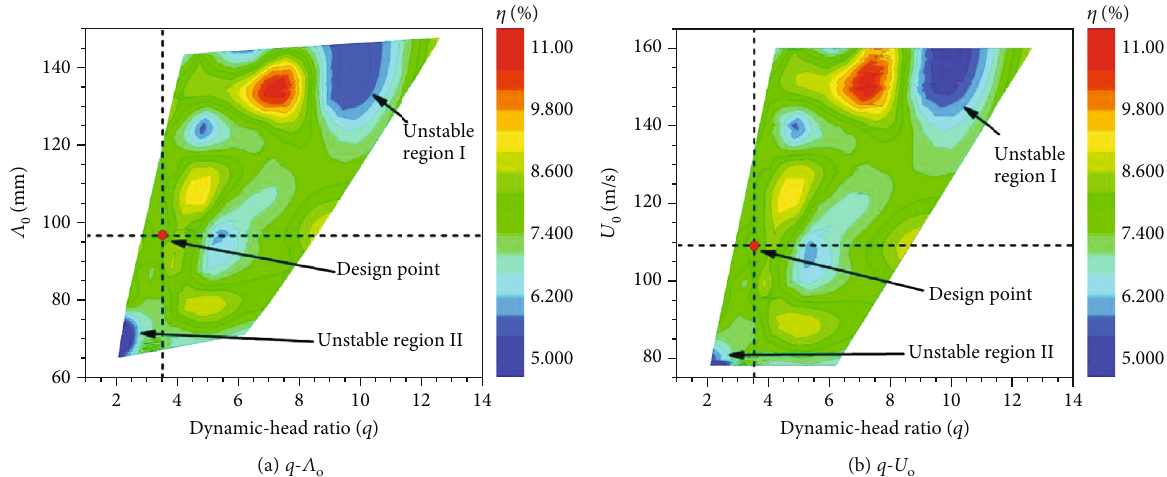
q − U o and (b) o under self-excited instability.